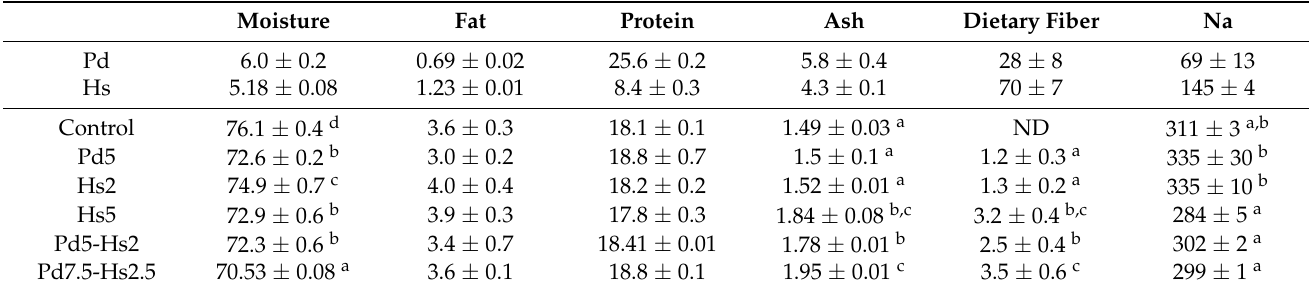
Table 1. Proximate composition (%) and Na content (mg/100 g) of Pd and Hs ingredients, and formulated beef